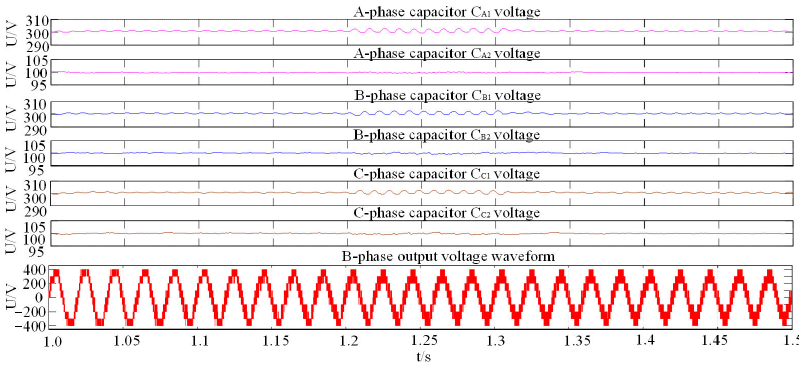
Figure 15. Capacitor voltage and B-phase output voltage